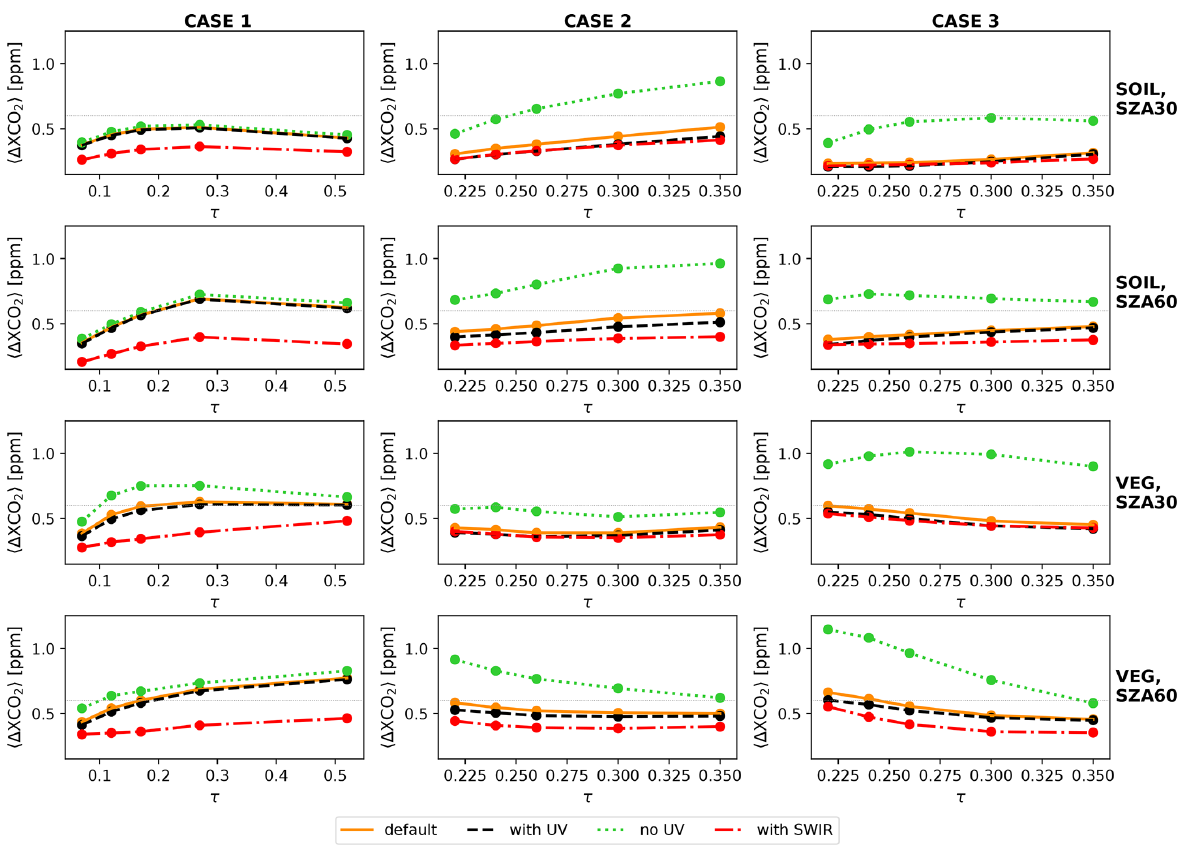
Figure 5. (cid:104) (cid:49) XCO 2 (cid:105) as a function of total aerosol optical depth at 765nm. The four lines in each panel represent four possible setups with different spectral range. (cid:104) (cid:49) XCO 2 (cid:105) is computed for the MAP-mod concept with five viewing angles, (cid:49)I/I = 3%, and (cid:49) DLP = 0 . 003. Table 8. MAP-band baseline